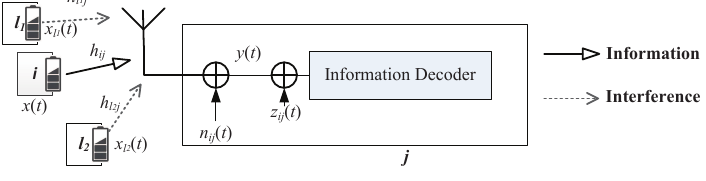
Figure 3. Wireless information transmission (WIT) receiver.